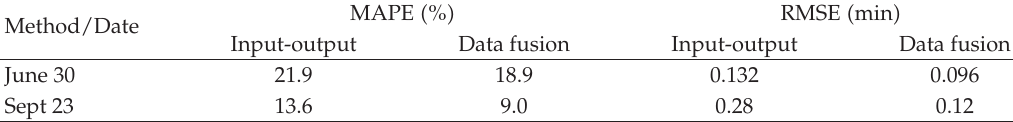
Table 1: Performance of models in terms of MAPE and RMSE for